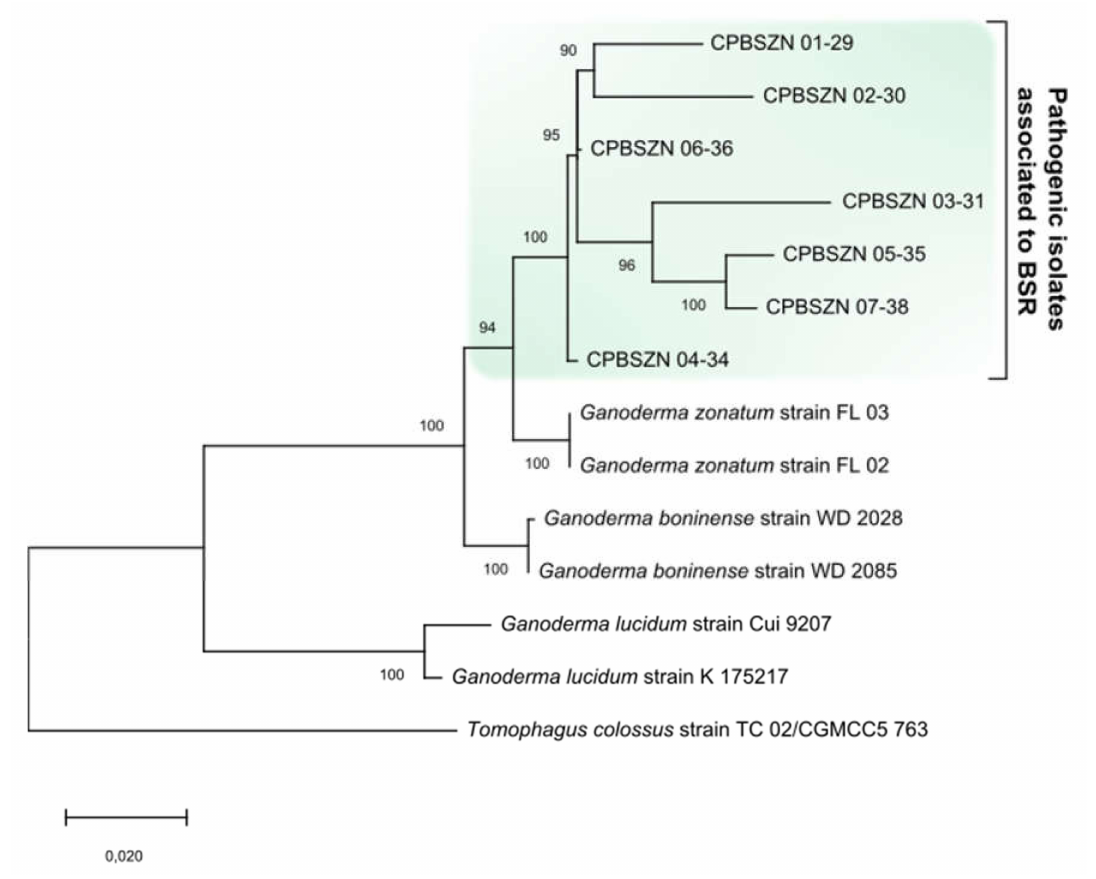
Figure 8. Phylogenetic tree of isolates associated with BSR based on data provided by a combination of the ITS , rpb2 , and tef1 α regions. The numbers above the nodes represent bootstrap values. The topology and values are derived from maximum likelihood